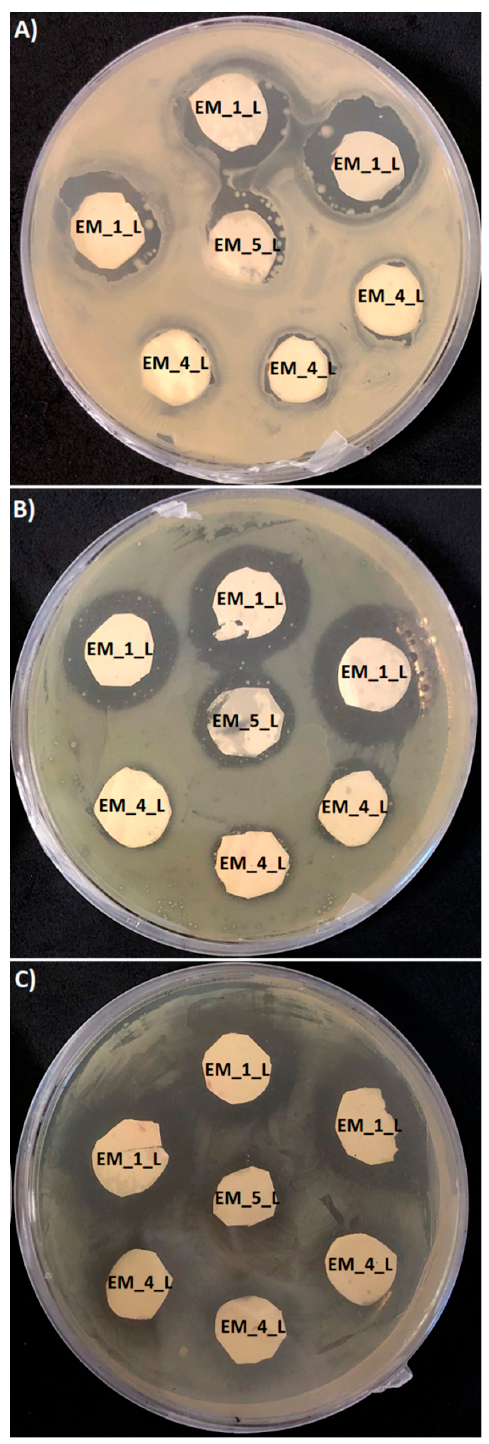
Figure 6. Antimicrobial activity of PHB electrospun meshes M_1_L, M_4_L and M_5_L tested against ( A ) Micrococcus luteus , ( B ) Serratia marcescens , and ( C ) Escherichia coli .